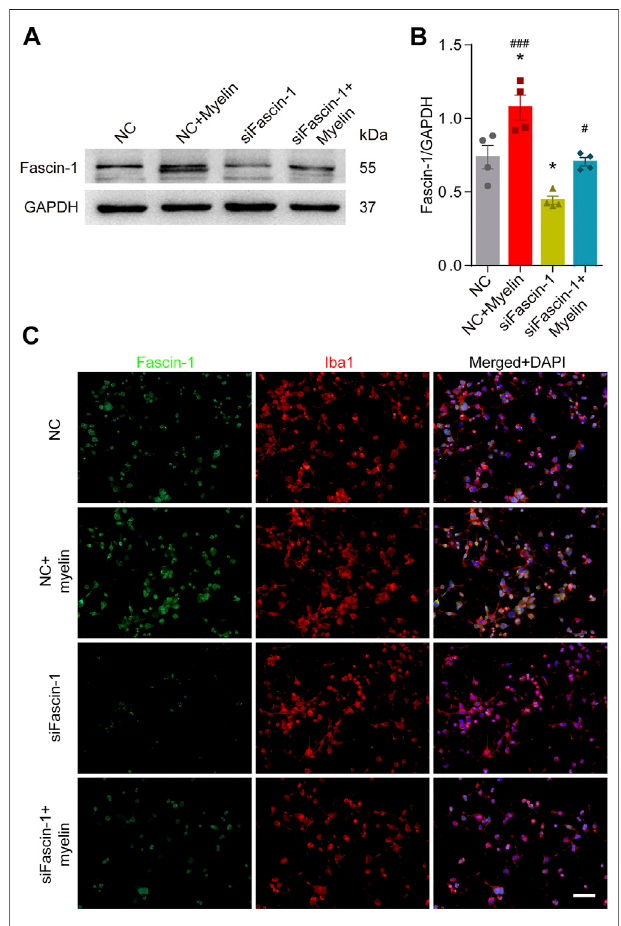
FIGURE 5 | Inhibition of Fascin-1 expression using siRNA in BV-2 microglia can be partly rescued by treatment with myelin. (A) Western blot analysisshowsthatcomparedtothenonspeci fi ccontrol(NC),Fascin-1siRNA (siFascin-1) could knockdown the expression of Fascin-1, while myelin treatment could upregulate the expression of Fascin-1. (B) Quantitative analysis of Fascin-1 expression in (A) . GAPDH was used as the loading control. The blots ( n (cid:2) 4 per group) were quanti fi ed as previously described. The results are expressed as the mean ± SEM. * p < 0.05 (NC + Myelin or siFascin-1 vs NC); # p < 0.05 (NC + Myelin vs siFascin-1), ### p < 0.001 (siFascin-1+Myelin vs siFascin-1). (C) BV-2 cells were transfected with nonspeci fi c control (NC) siRNA or siFascin-1 for 24 h and then treated with or without myelin for an additional 24 h in complete medium. Representative immuno fl uorescence images of Fascin-1 (Green) and Iba1 (Red) are shown. DAPI (Blue) was used to stain the nuclei. Scale bar: 100 μ m.